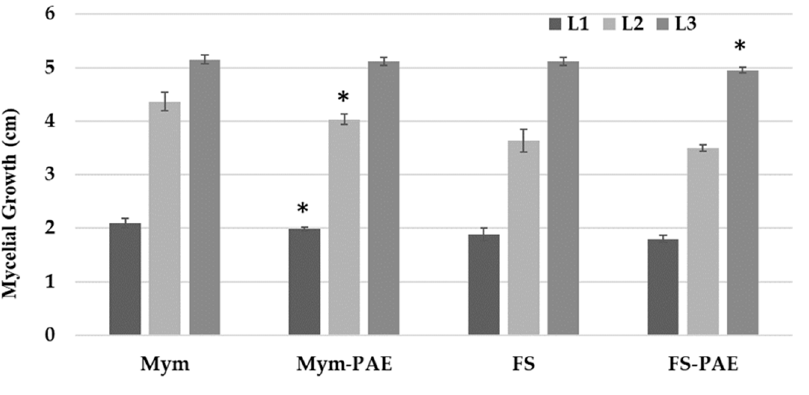
Figure 6. Effect of volatile metabolites of P. variotii on mycelial growth of M. melonis and F. solani . L1, L2, and L3: measurements performed every two days. Data were analysed using Student’s t -test. Means with * denote significant difference between both treatments according a pairwise comparison using Student’s t-test ( p < 0.05).